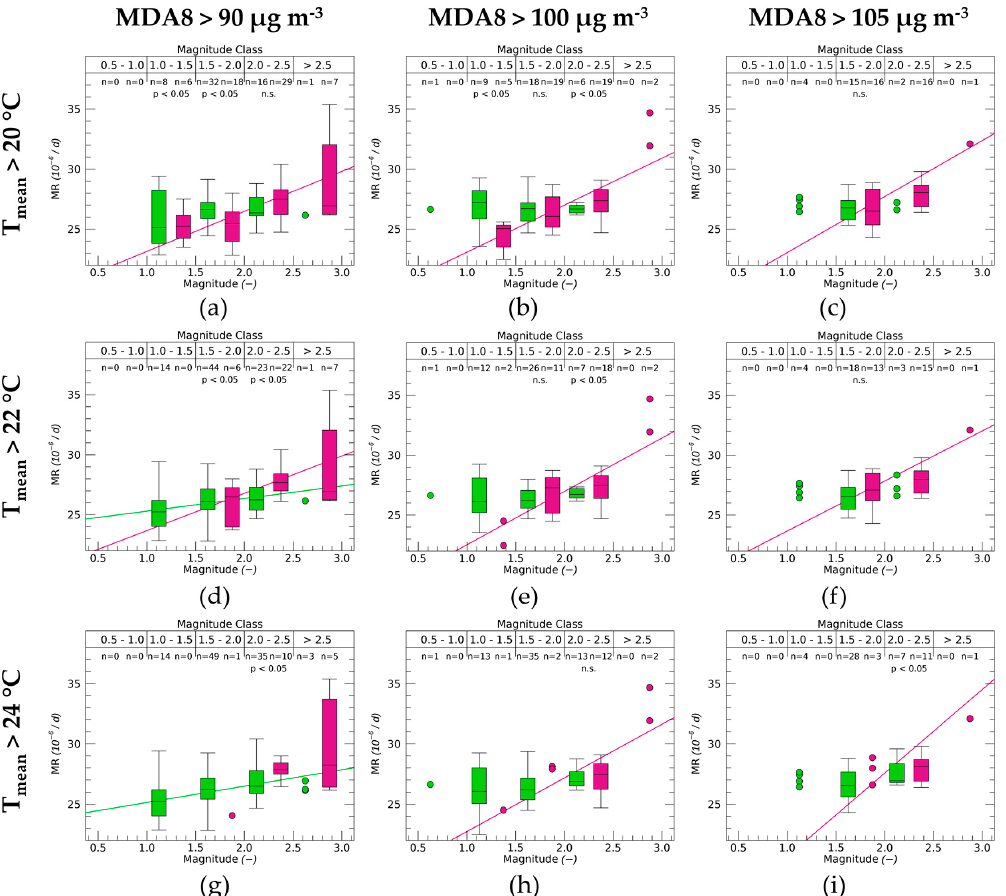
Figure 7. Comparison of OEs (green bars) and OEc (purple bars) with MDA8 as a predictor variable ( x -axis) for the daily mortality rates ( y -axis) for different threshold combinations (( a ) T mean > 20 °C, MDA8 > 90 µg m − 3 ; ( b ) T mean > 20 °C, MDA8 > 100 µg m − 3 ; ( c ) T mean > 20 °C, MDA8 > 105 µg m − 3 ; ( d )